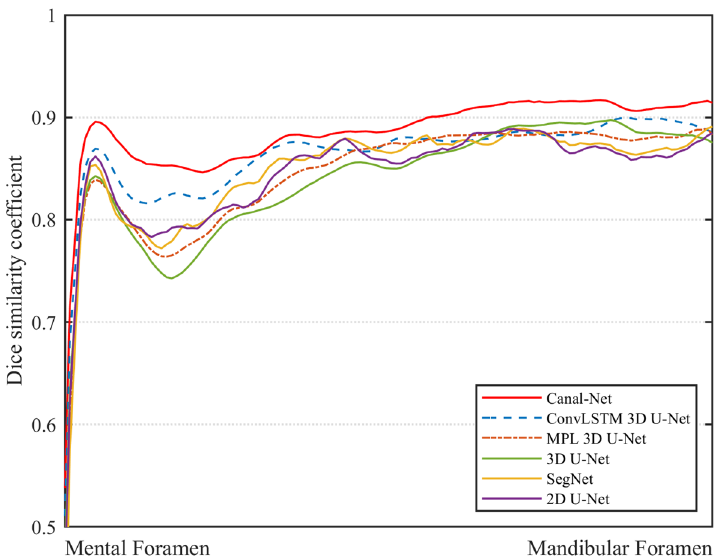
Figure 5. The line plots of dice similarity coefficient score (DSC) from the mental foramen to the mandibular foramen for Canal-Net (ours), ConvLSTM 3D U-Net (ours), MPL 3D U-Net (ours), 3D U-Net, SegNet, and 2D U-Net.